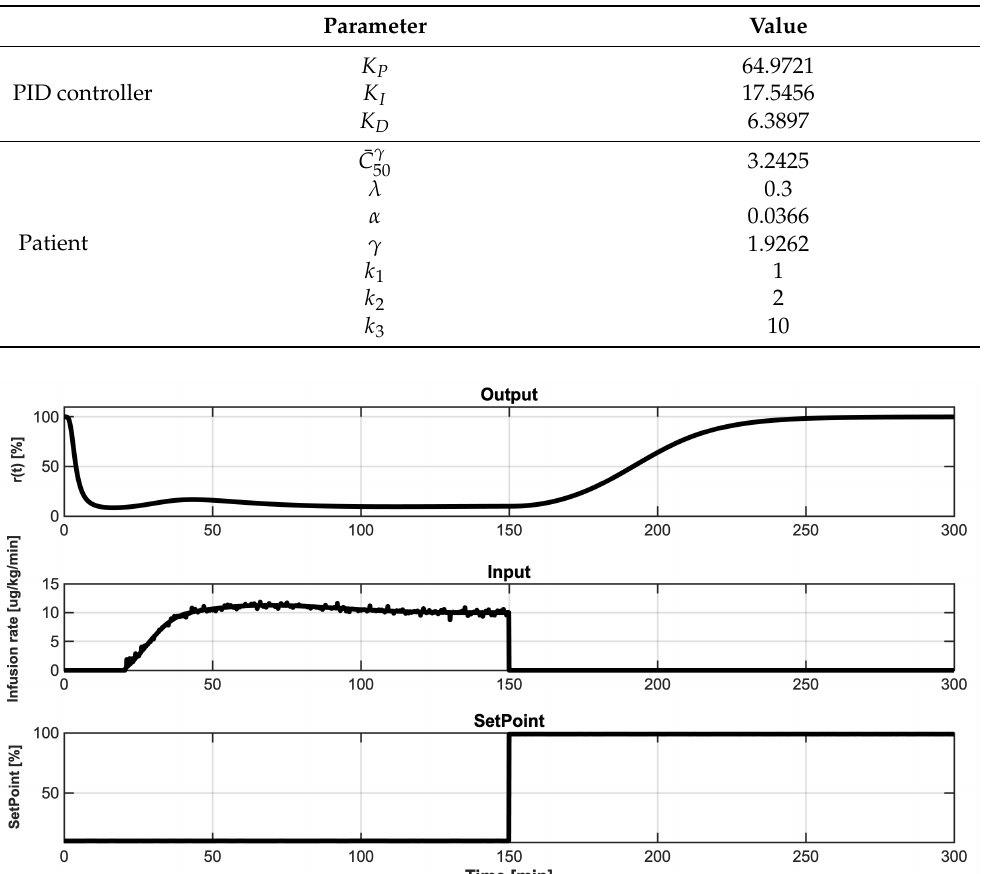
Figure 3. SIMULINK model for the closed-loop administration of atracurium. Table 2. Simulation settings for PID controller gains and parameters of patient number 17.